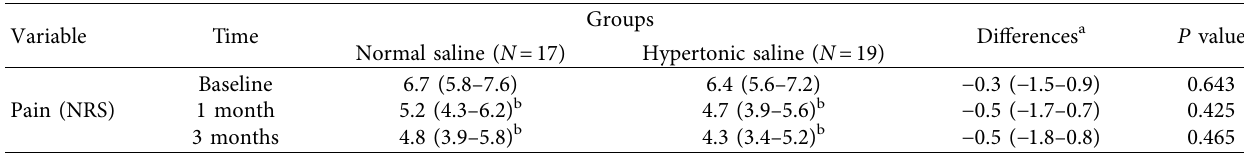
A numerical rating scale (NRS) was used to assess the intensity of postherpetic neuralgia pain. A mixed linear model was used in the statistical analysis. Te data are presented as the estimated mean with a 95% confdence interval. Te group diference was not signifcant ( P � 0.380). Te time efect was signifcant ( P < 0.001). Te P value of the interaction between the group and time was not signifcant ( P � 0.942). a Estimated diference in values between groups. b P < 0.001 compared with the baseline in each